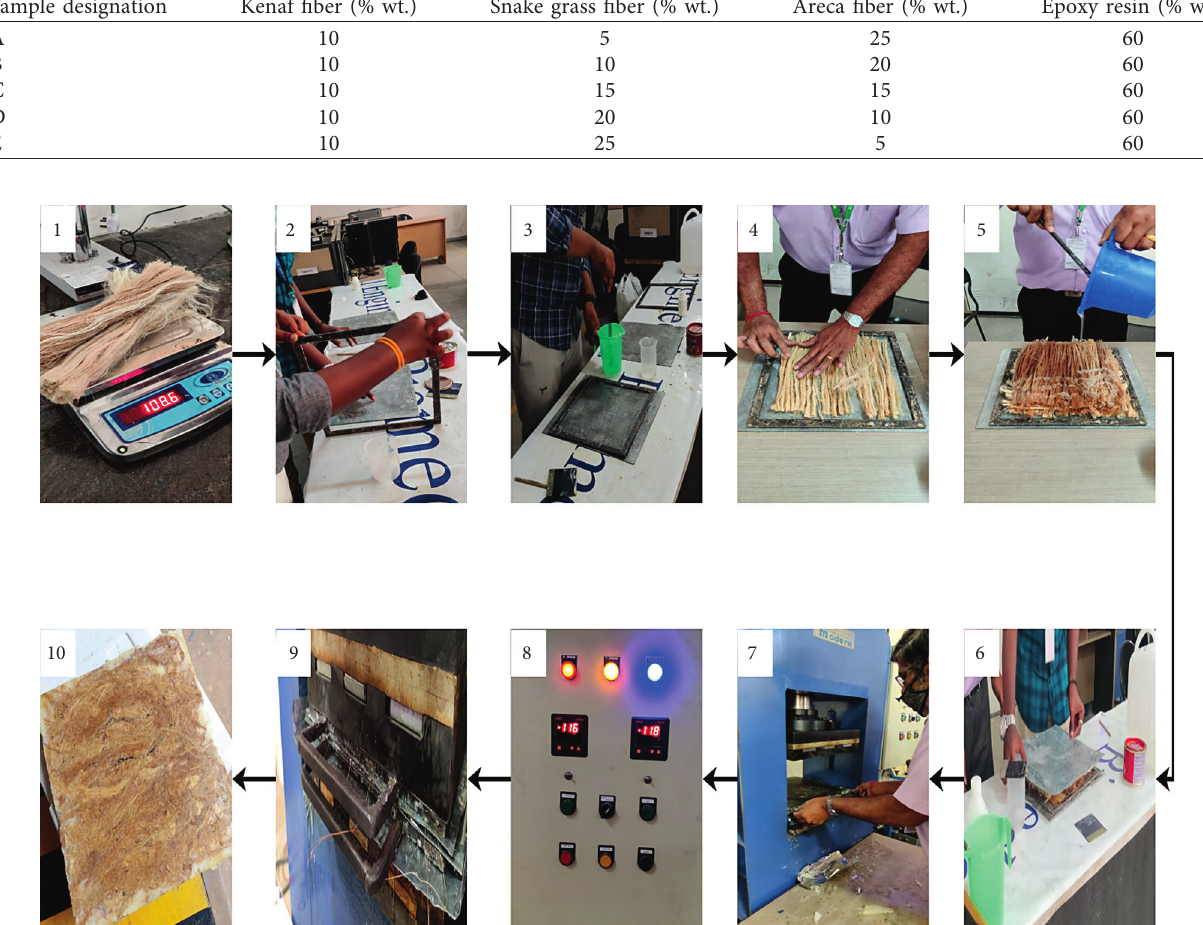
Figure 1: Graphical procedure of fabrication process.